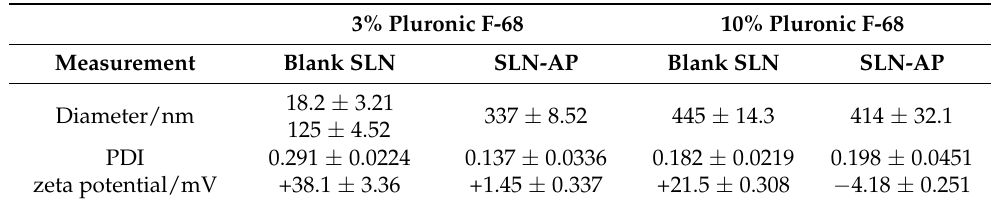
Table 1. Characterization of blank solid lipid nanoparticles (blank SLN) and ascorbyl palmitate- loaded solid lipid nanoparticles (SLN-AP). Before measurement, samples were diluted 10 × in ultra- pure water. Average size, polydispersity and zeta potential were measured on Zetasizer, Malvern Panalytical. Data are expressed as mean ± ( n ≥ 3).